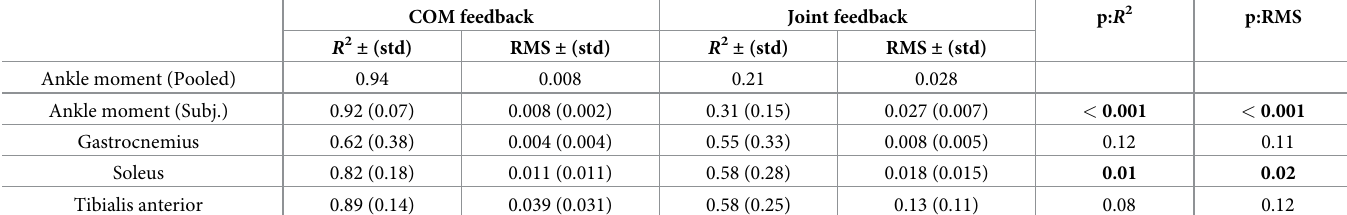
Table 1. Perturbed standing (data from [26]). RMSE and R 2 values of the reconstruction of the ankle joint moment and calf muscle activity in perturbed standing with COM feedback or ankle joint kinematics feedback. Joint moments are reported pooled over all subjects (Pooled) and for individual subjects (Subj.) with the standard devia- tion over subjects (std). P-values are reported of the paired ttest that compares the model with COM feedback and the model with ankle joint kinematics feedback. The results for muscle activity are only reported for individuals and not pooled over all subjects due to the limitations related to normalizing electromyography